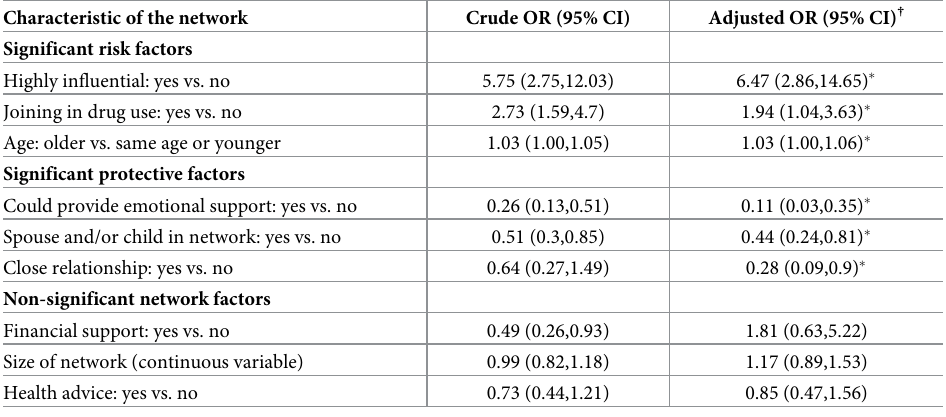
Table 3. Regression results of social network factors associated with result of urine test among MMT clinics in Kunming in Yunnan Provence, China (logistic regression predicting urine test: Positive vs. negative). Characteristic of the network Crude OR (95% CI) Adjusted OR (95% CI)